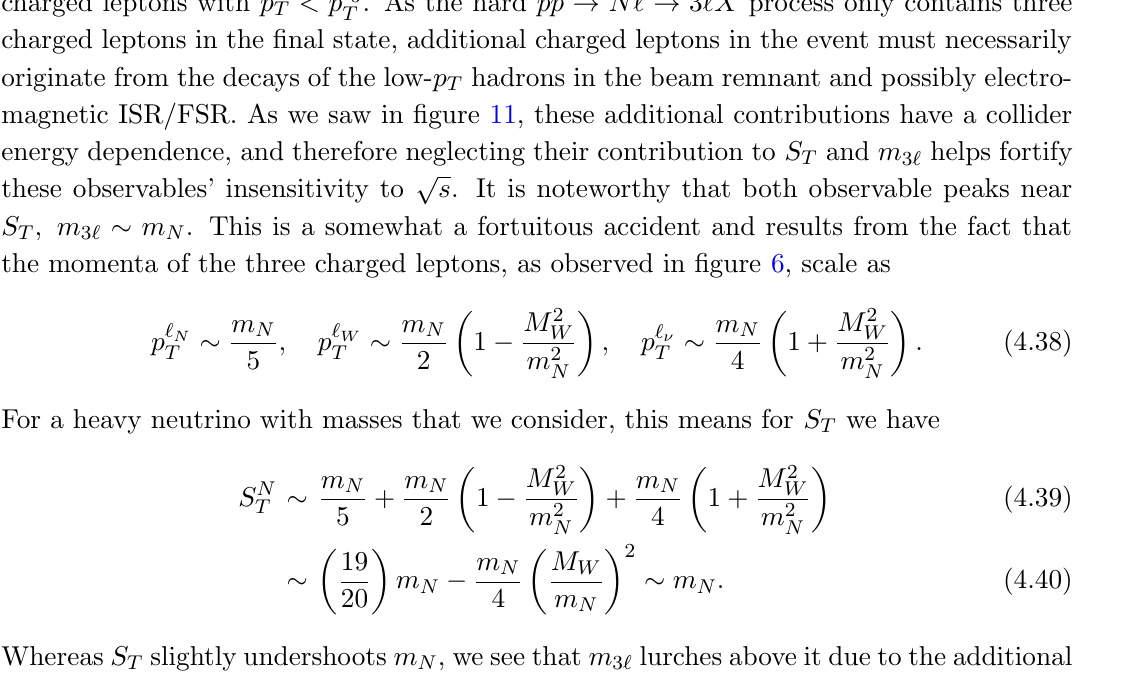
. As the hard pp N‘ 3 ‘X process only contains T ! !